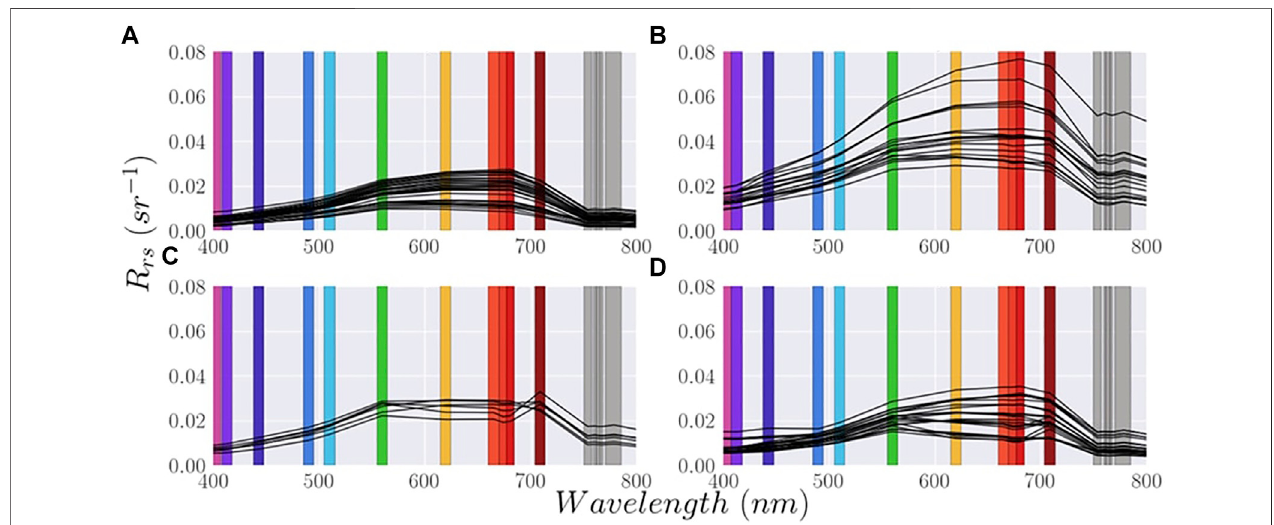
FIGURE4| R rs ( λ )simulatedforOLCIbandsin (A) July/2015(n=30), (B) March/2016(n=16), (C) Jun/2016(n=06),and (D) Aug/2017(n=22).Thecolorsbarsare representative to OLCI bands in the true visible colors of the electromagnetic spectrum and NIR.